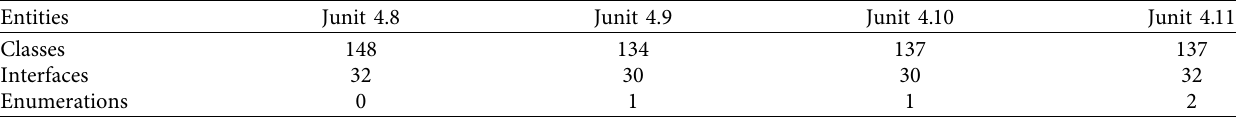
Table 15: Entities in Junit.